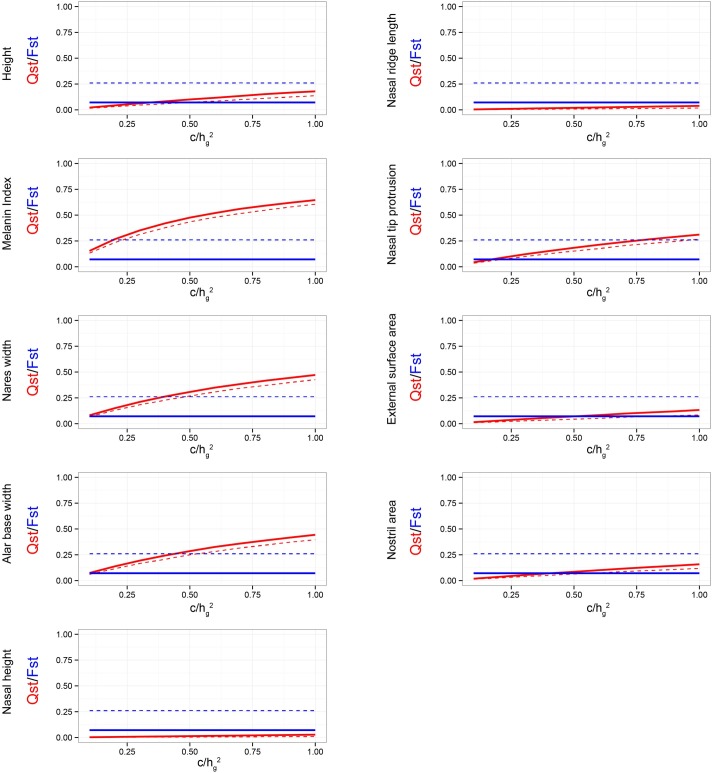
Sensitivity plots showing critical values of c/h2.Change in median Qst of height, skin pigmentation, and nose shape measures as a function of c/h2 is shown as a solid red line. Median Fst is shown as a solid blue line. The lower and upper 95% bounds for Qst and Fst are shown as dashed red and blue lines, respectively. The critical value at which the lower bound of Qst meets the upper bound of Fst is shown on the upper left corner of each plot. Lower critical values indicate the Qst–Fst is more robust to c/h2 assumptions.